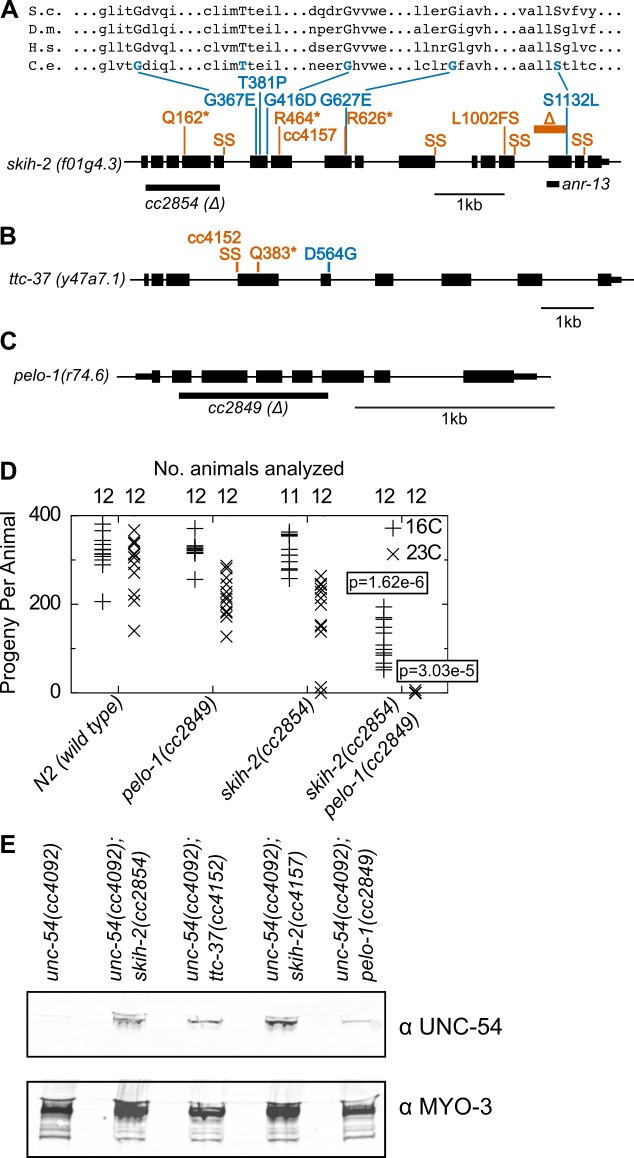
Protein factors required for nonstop mRNA decay.(A) Diagram of the skih-2 gene, with mutations identified in the cc4092 screen. Red indicates mutations expected to prematurely terminate SKIH-2 protein synthesis. SS is a mutation of a splice site. Blue indicate missense mutations, with multiple sequence alignment of these residues with skih-2 homologs above. L1002FS is a frameshift mutation. ‘S.c.’ is S. cerevisiae; ‘D.m.’ is D. melanogaster; ‘H.s.’ is H. sapiens and ‘C.e.’ is C. elegans. A ~ 1 kb deletion introducing a premature stop codon made by CRISPR/Cas9 and used in subsequent characterization is indicated below the gene. See also Figure 1—figure supplement 1, Figure 2—figure supplement 1, Figure 2—figure supplement 2. (B) Diagram of the ttc-37 gene, a ski3 homolog, with mutations identified in the cc4092 screen. Coloring as in (A). (C) Sequence homolog and candidate ortholog of dom34/pelota. ~700 bp deletion made by CRISPR/Cas9 and used in subsequent characterization is indicated below the gene. See also Figure 1—figure supplement 1, Figure 2—figure supplement 3. (D) Brood size analysis for the indicated strains. Each symbol represents brood size of one animal, with total number of animals analyzed indicated at top. See Materials and methods. p-Value from Mann Whitney U test compared with any other strain at the same temperature. (E) Immunoblot on an equal number of animals of the indicated genotypes.